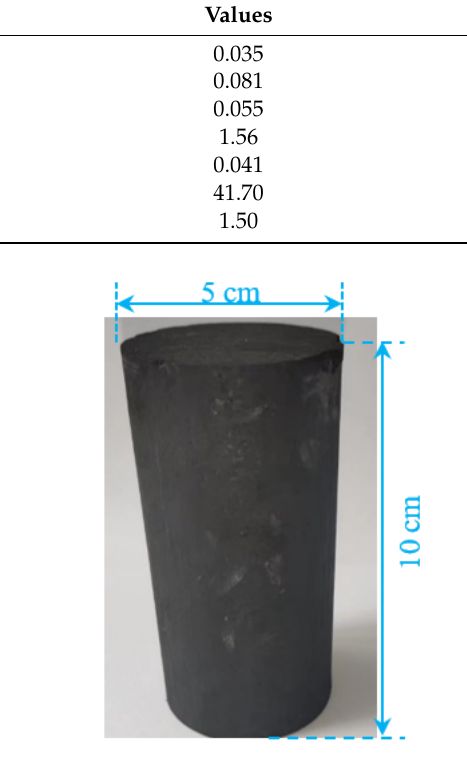
Figure 1. Experimental platform and coal sample.